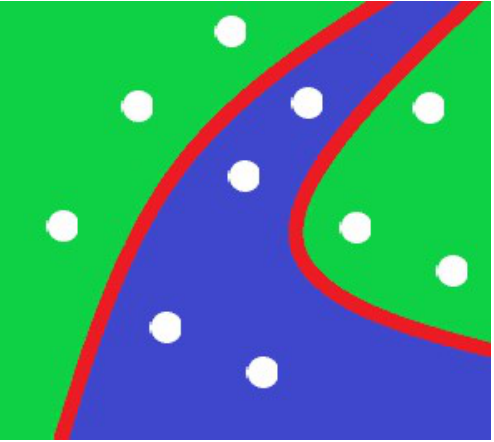
Figure 1. Classification curve generated by SVM with two